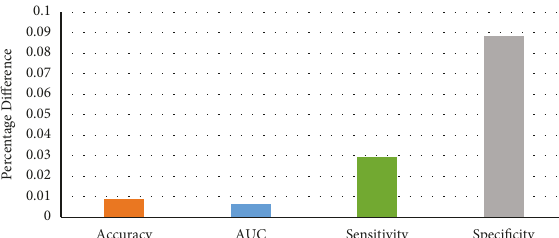
Figure 5: Percentage difference between accuracy, AUC, sensitivity, and specificity on GT data and forecasted